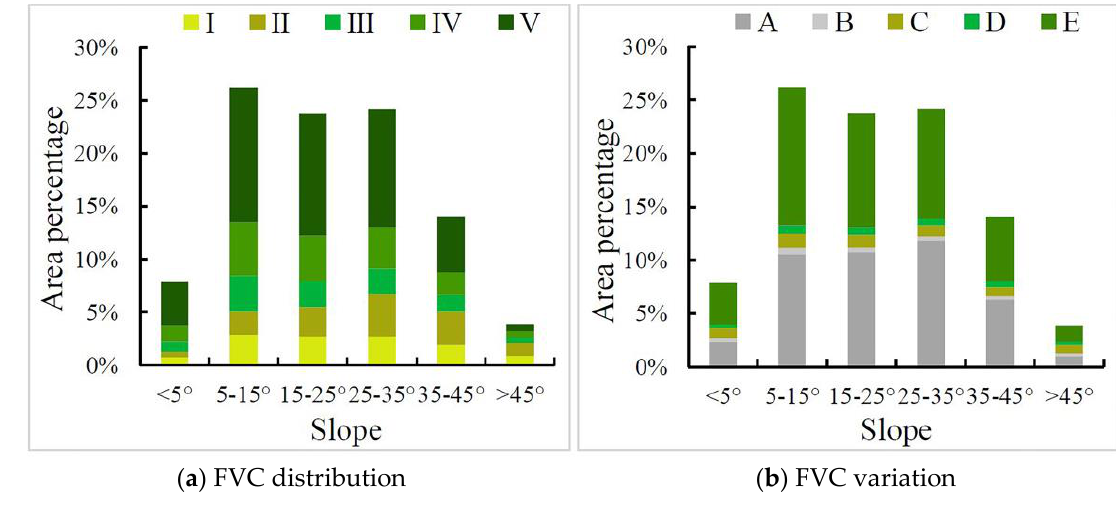
Figure 11. Distribution ( a ) and variation ( b ) of FVC for different slopes.